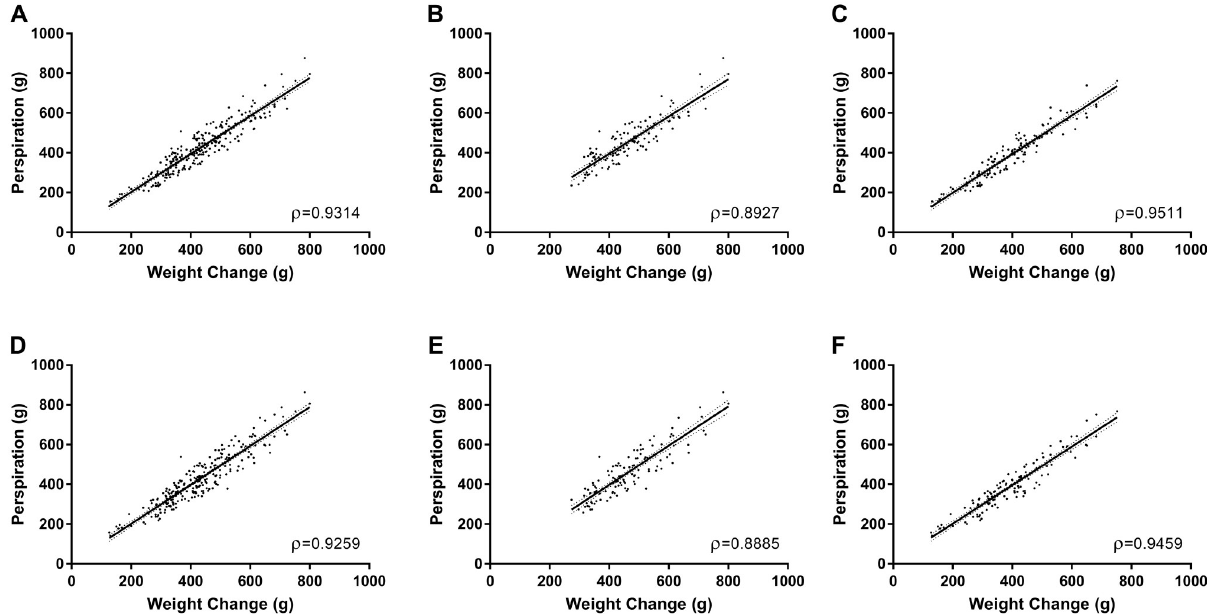
Fig 2. Comparison of participant weight change with perspiration. Data represent Pearson ( ρ ) correlation with accompanying linear regression line of final weight change (g) versus DBM device-measured water loss (perspiration, g). Samsung Gear S2: (A) All participants. (B) Men. (C) Women. Samsung Gear Fit2: (D) All participants. (E) Men. (F) Women. Solid line, regression best fit; dotted lines, upper and lower bounds of 95%CI of the regression line. Correlation, all measures: p < 0.0001. For all regressions, there were no significant deviations from linearity (slopes were all significantly non-zero, p <